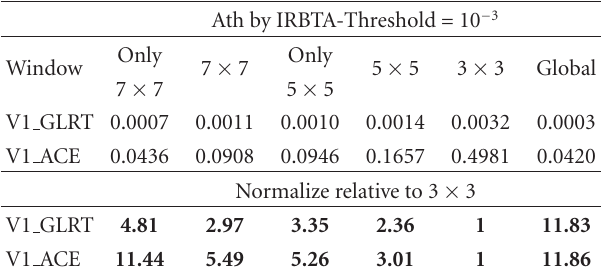
Table 7: The A th (( A − th 2 )/(th − th 2 )) where A is the area under the Pd-log ( P fa ) curve and th is the threshold (i.e., the maximum false alarm rate) results of the IRBTA algorithm for V1 in the RIT test image are shown in the first two lines. The maximum false alarm rate is 10 − 3 ; other parameters are as given in Table 6. The third and fourth lines represent the same results normalized by dividing the value of the 3 × 3 filter by the values of the other filters. Ath by IRBTA-Threshold = 10 −